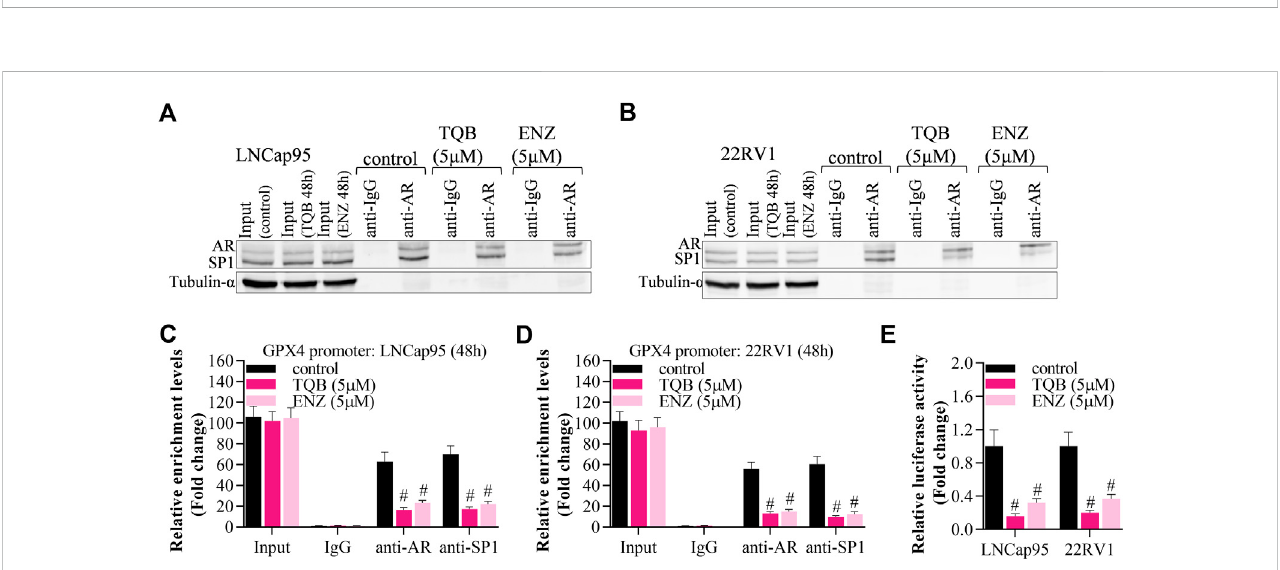
FIGURE 5 TQB3720impaired GPX4expressionbyinhibitingARbindingtoSP1 (A,B) Co-IP